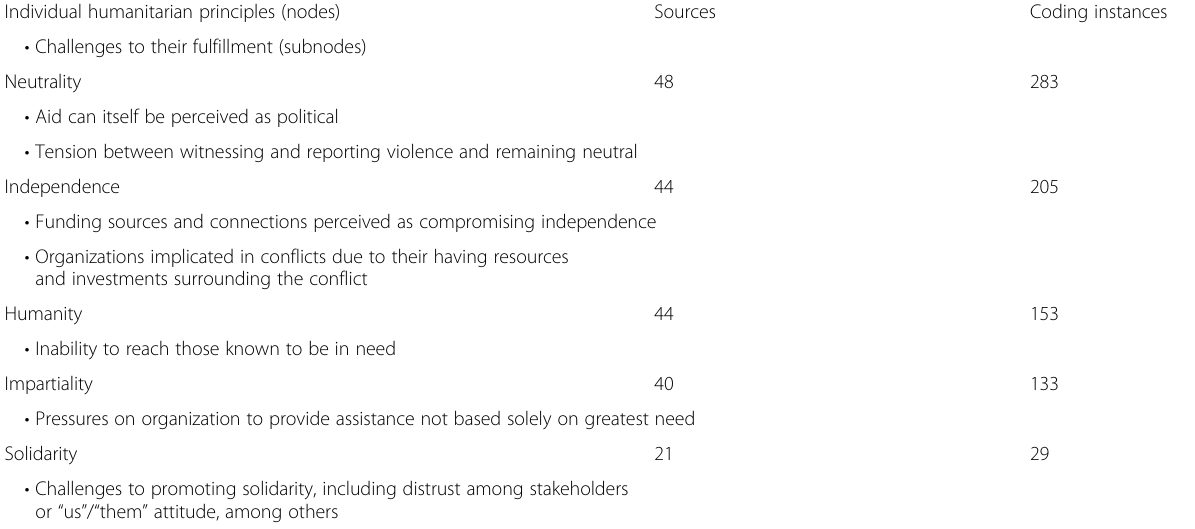
Table 2 Coding frequencies of humanitarian principles, including the top coded challenges Individual humanitarian principles (nodes)